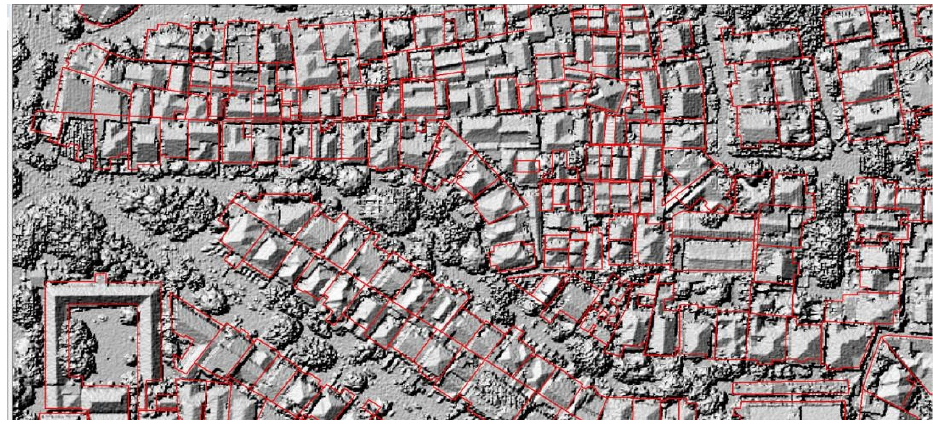
Figure 4. Hill-shade effect on LiDAR 3D model (source: data processing documentation).